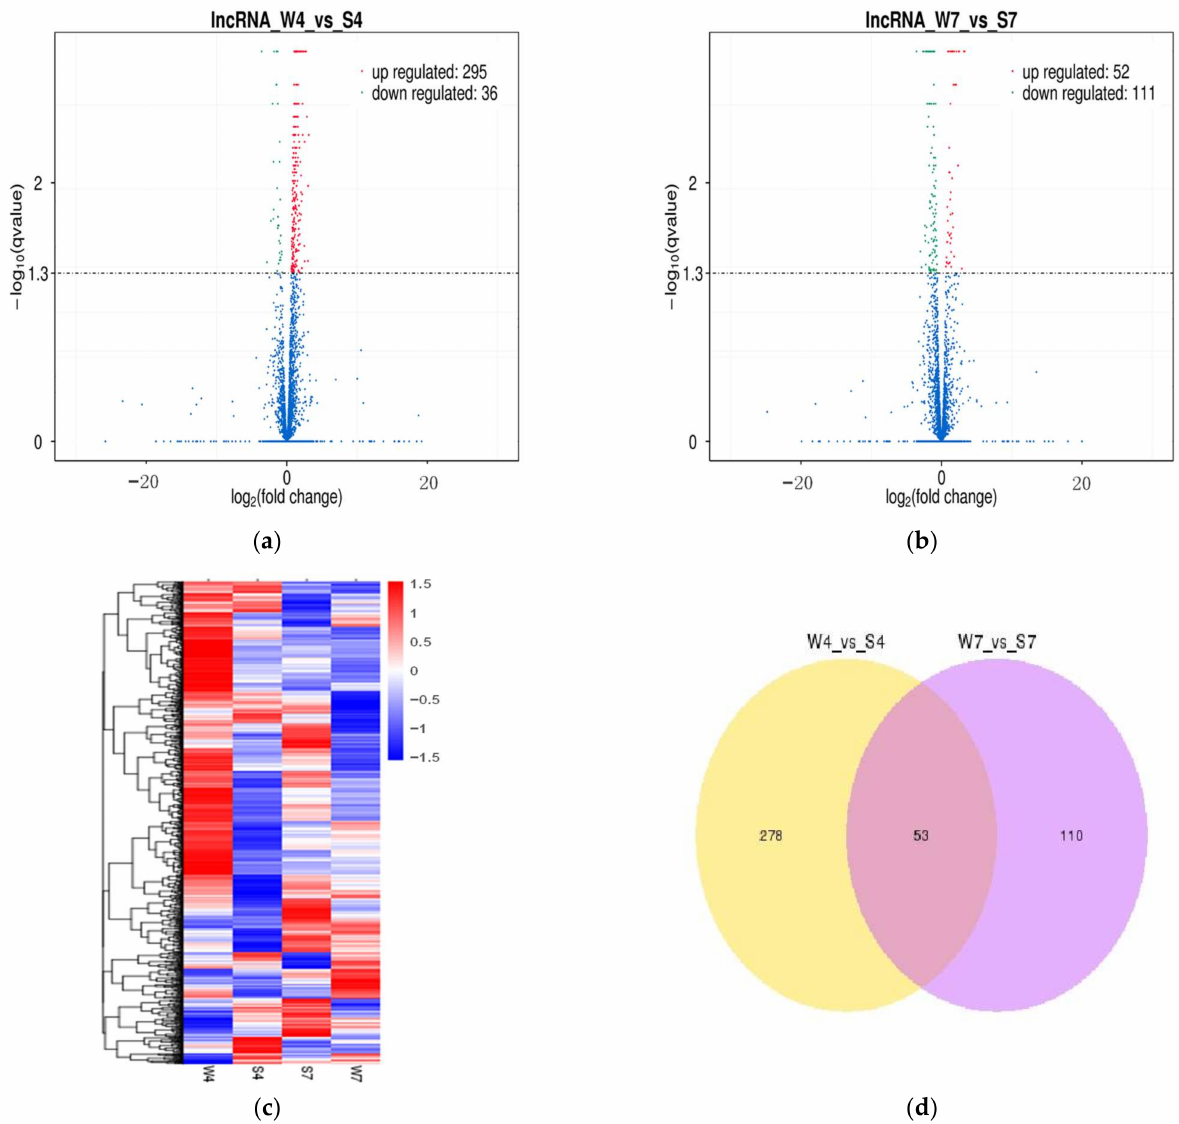
Figure 3. Differential expression analysis of intestinal lncRNAs of piglets between the weaning group and suckling group. ( a ) Volcano plot of DElncRNAs in W4 vs. S4; ( b ) volcano plot of DElncRNAs in W7 vs. S7. (a, b) Red dots represent up-regulated genes, green dots represent down-regulated genes, and blue dots represent non-differentially expressed genes; ( c ) clustered heat map of DElncRNAs based on the FPKM values in the weaning and suckling groups. Red and blue represent high and low expression levels, respectively; ( d ) Venn diagram of common DElncRNAs in W4 vs. S4 and W7 vs.